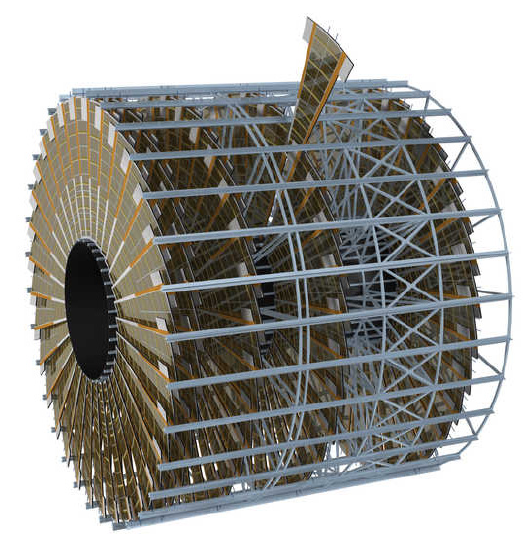
Figure 1. Turbo-fan end-cap support structure